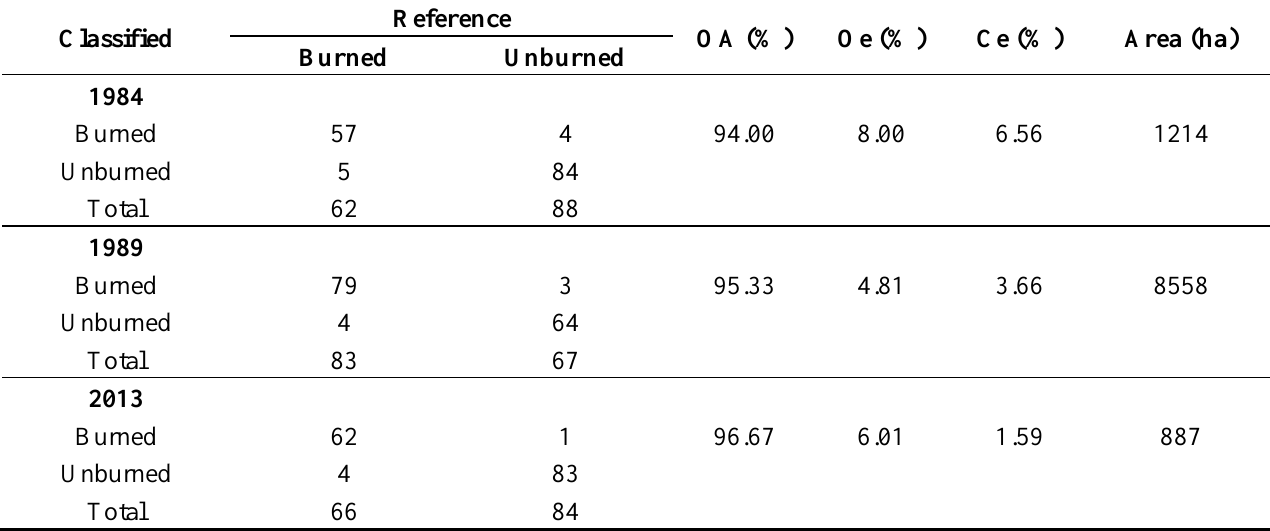
Table 2. Accuracy assessment results for the classifications of the burned areas. Overall accuracy (OA), Omission (Oe), and Commission (Ce) errors are estimated based on the error matrix. The estimated size of the burned areas that were classified by the object-based image analysis is also